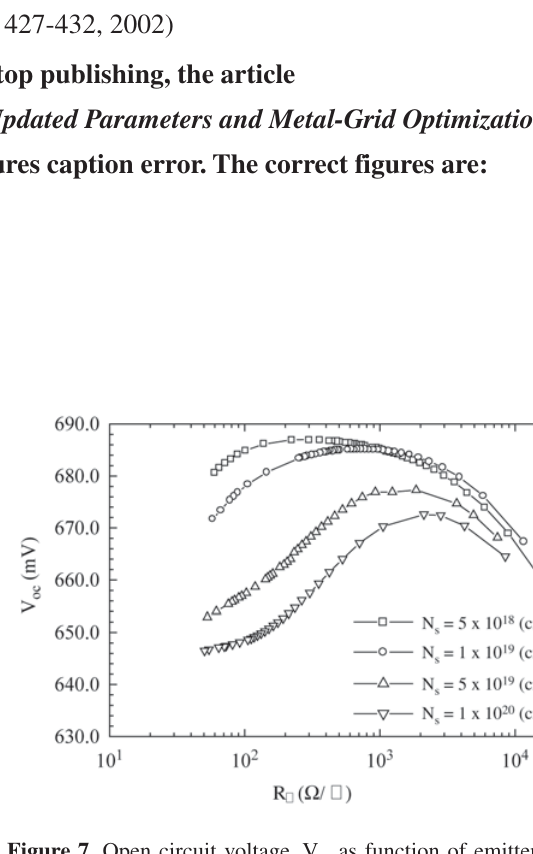
and surface doping level, N (cid:0)